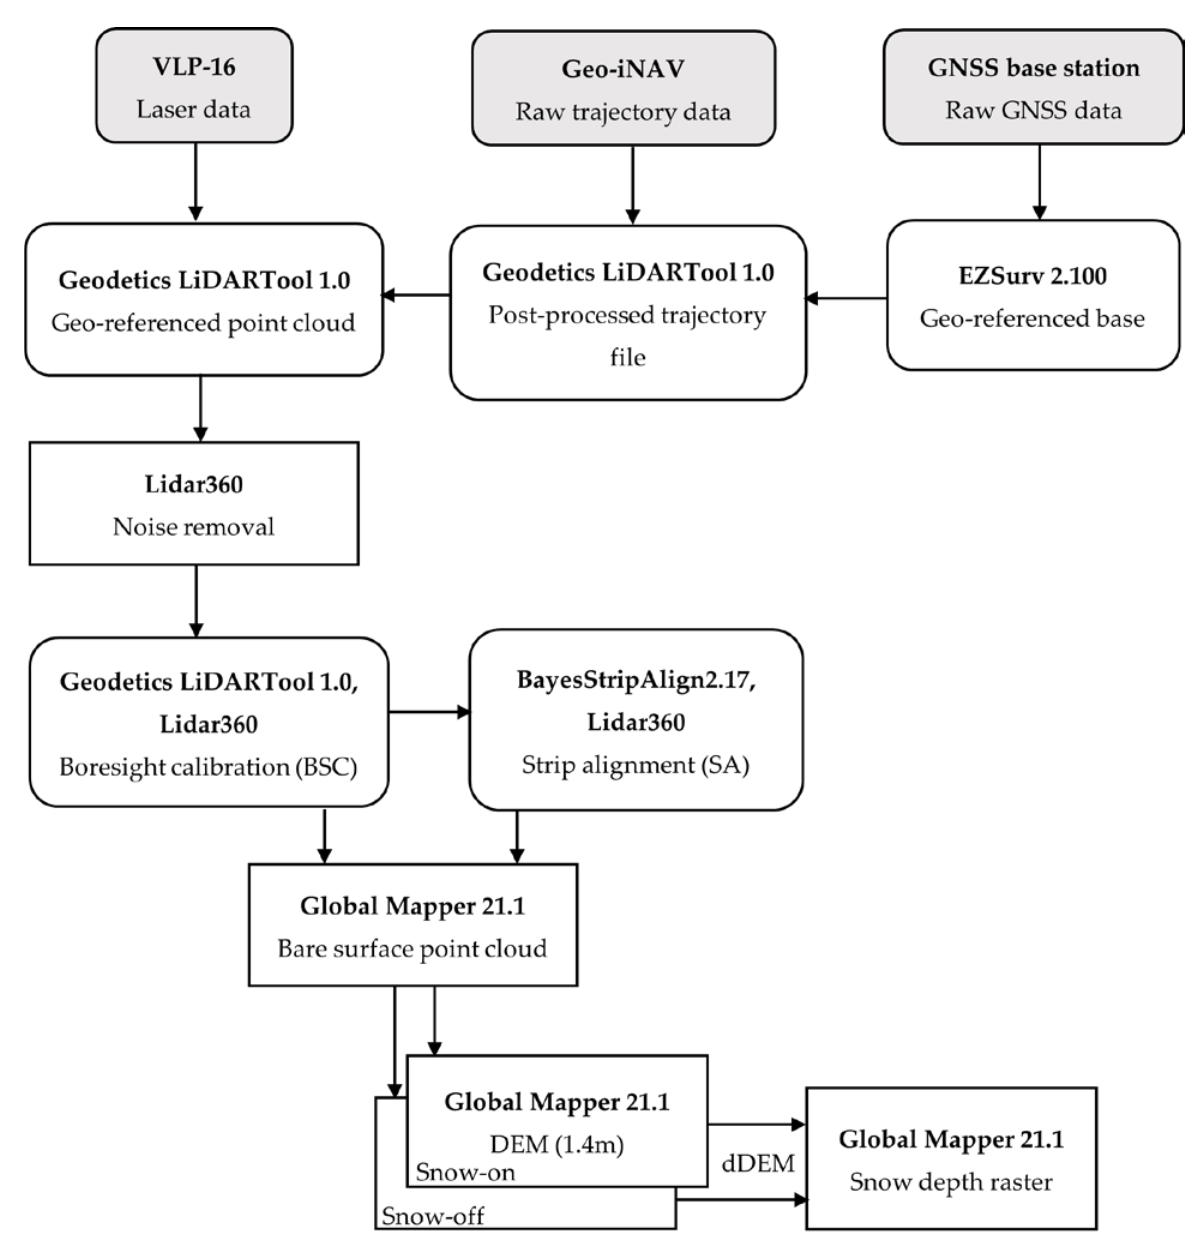
Figure 5. Data processing workflow of lidar data. Each box shows the software used (bold) with the corresponding end product.